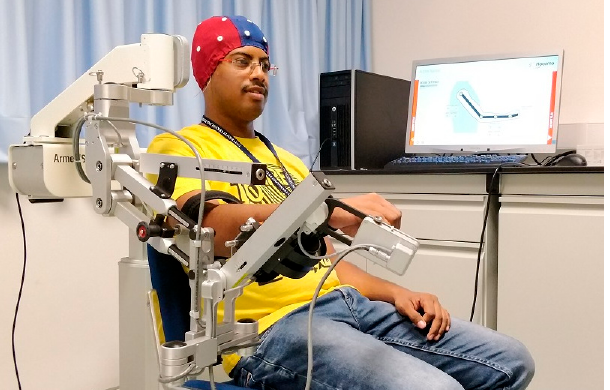
Figure 6. Upper limb (ArmeoSpring) at SMART Lab, Figure 6 Upper limb (ArmeoSpring) at SMART Lab, UTP